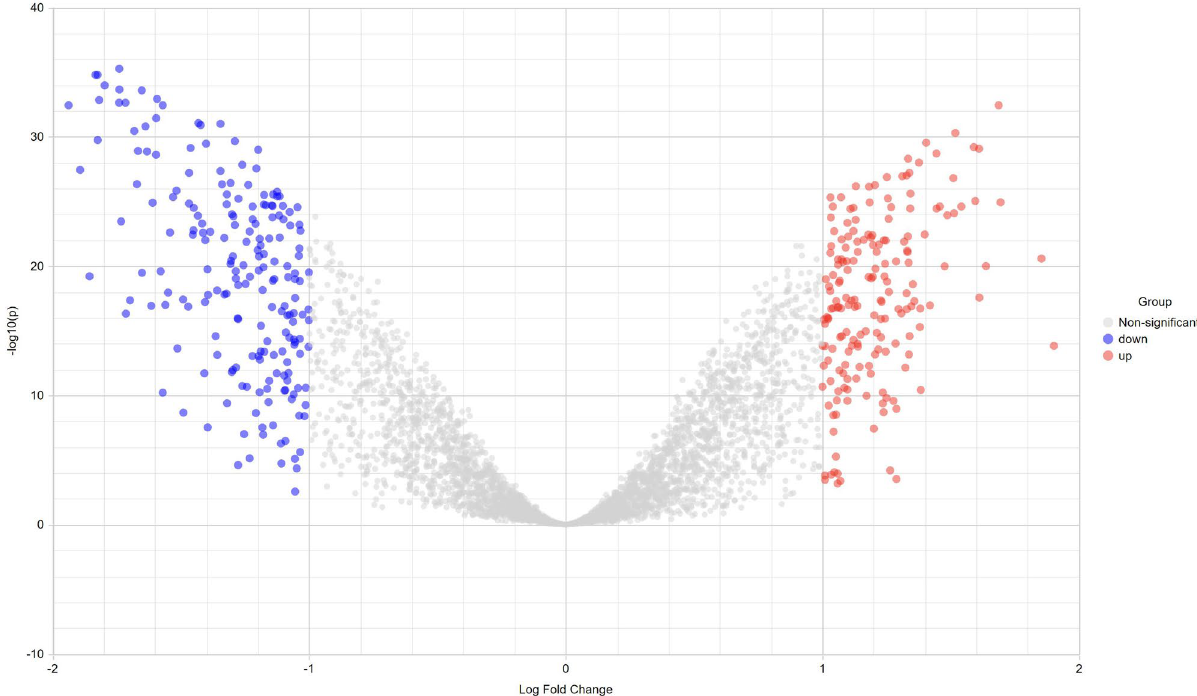
Figure 1. Volcano plot of the differential gene expression of immune genes of human. The scattered points indicate the up and down regulated and non-significant genes based on the threshold applied. Red spheres represent up regulation, blue spheres represent the down regulation and black spheres represent non-significant genes.